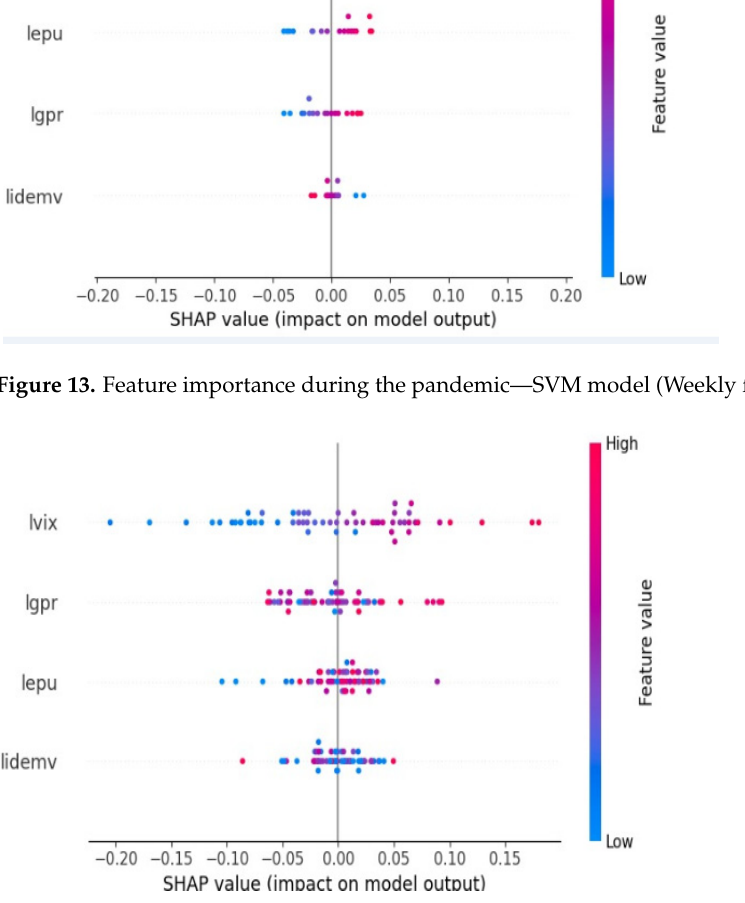
Figure 14. Feature importance during the pandemic—XGBoost model (Weekly frequency).